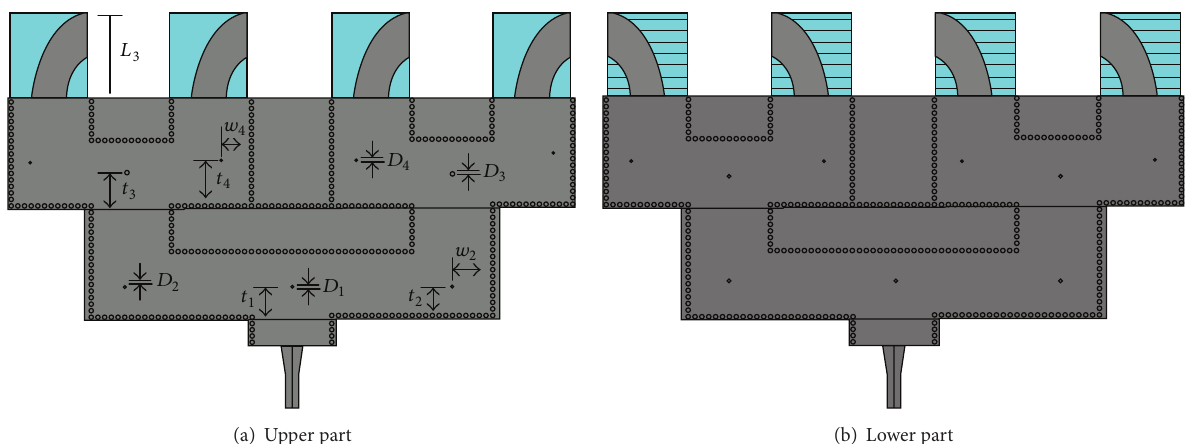
Figure 9: Simulation model of the SIW Vivaldi antenna array.